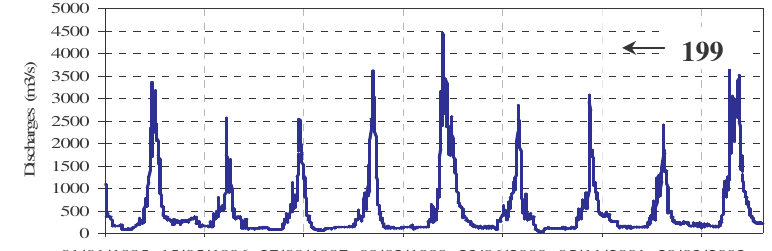
Figure 2: Time Series of Discharge at Bakel